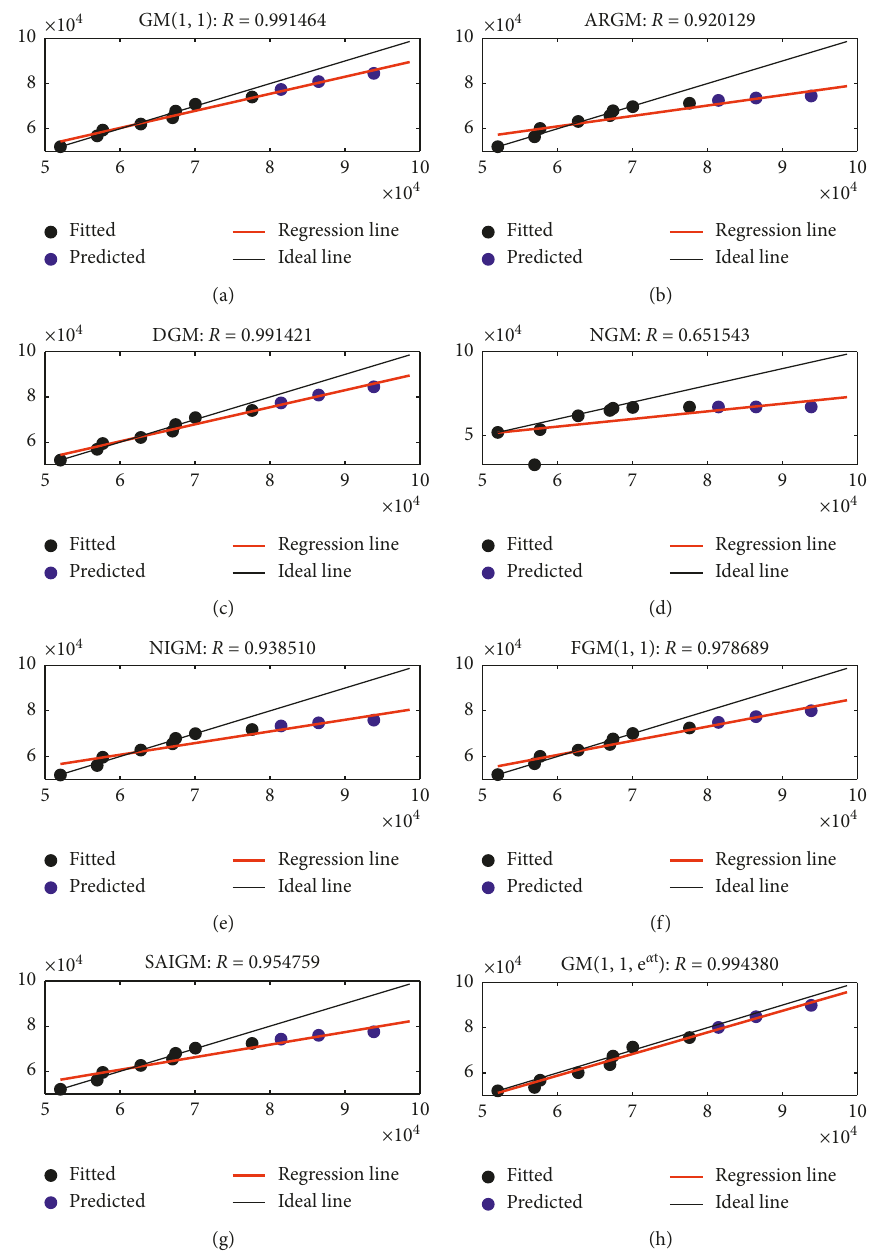
Figure 8: Comparison of the true value and the produced value by different grey models in Case the WOA algorithm. Compared with seven classical grey prediction methods such as ARGM, DGM, NGM, NIGM, FGM(1,1), GM(1,1), and SAIGM, the proposed grey model